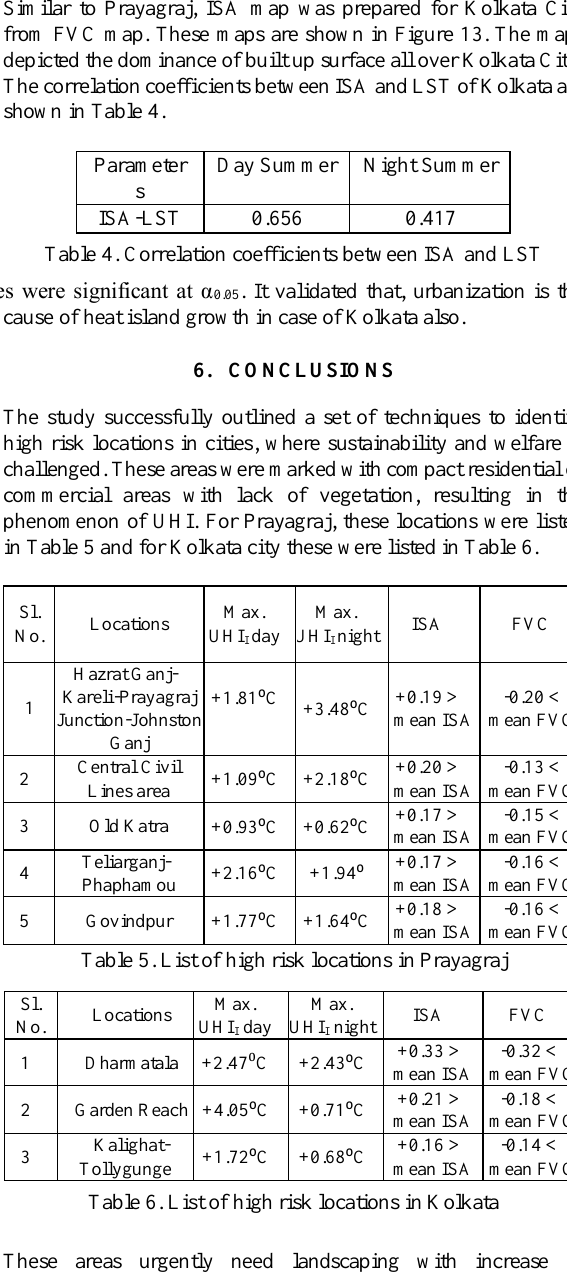
Figure 13. FVC and ISA indices for Kolkata, 2018 The average LST of the LULC classes in Kolkata are listed in Table 3. The average LST values were highest for dense urban areas. The LST was 1.33 ⁰ C higher than the average in vegetated land. The mixed urban and fields also showed higher LST pattern than green areas. These values depicted that, the LST pattern within a city region varies greatly with land cover characteristics.